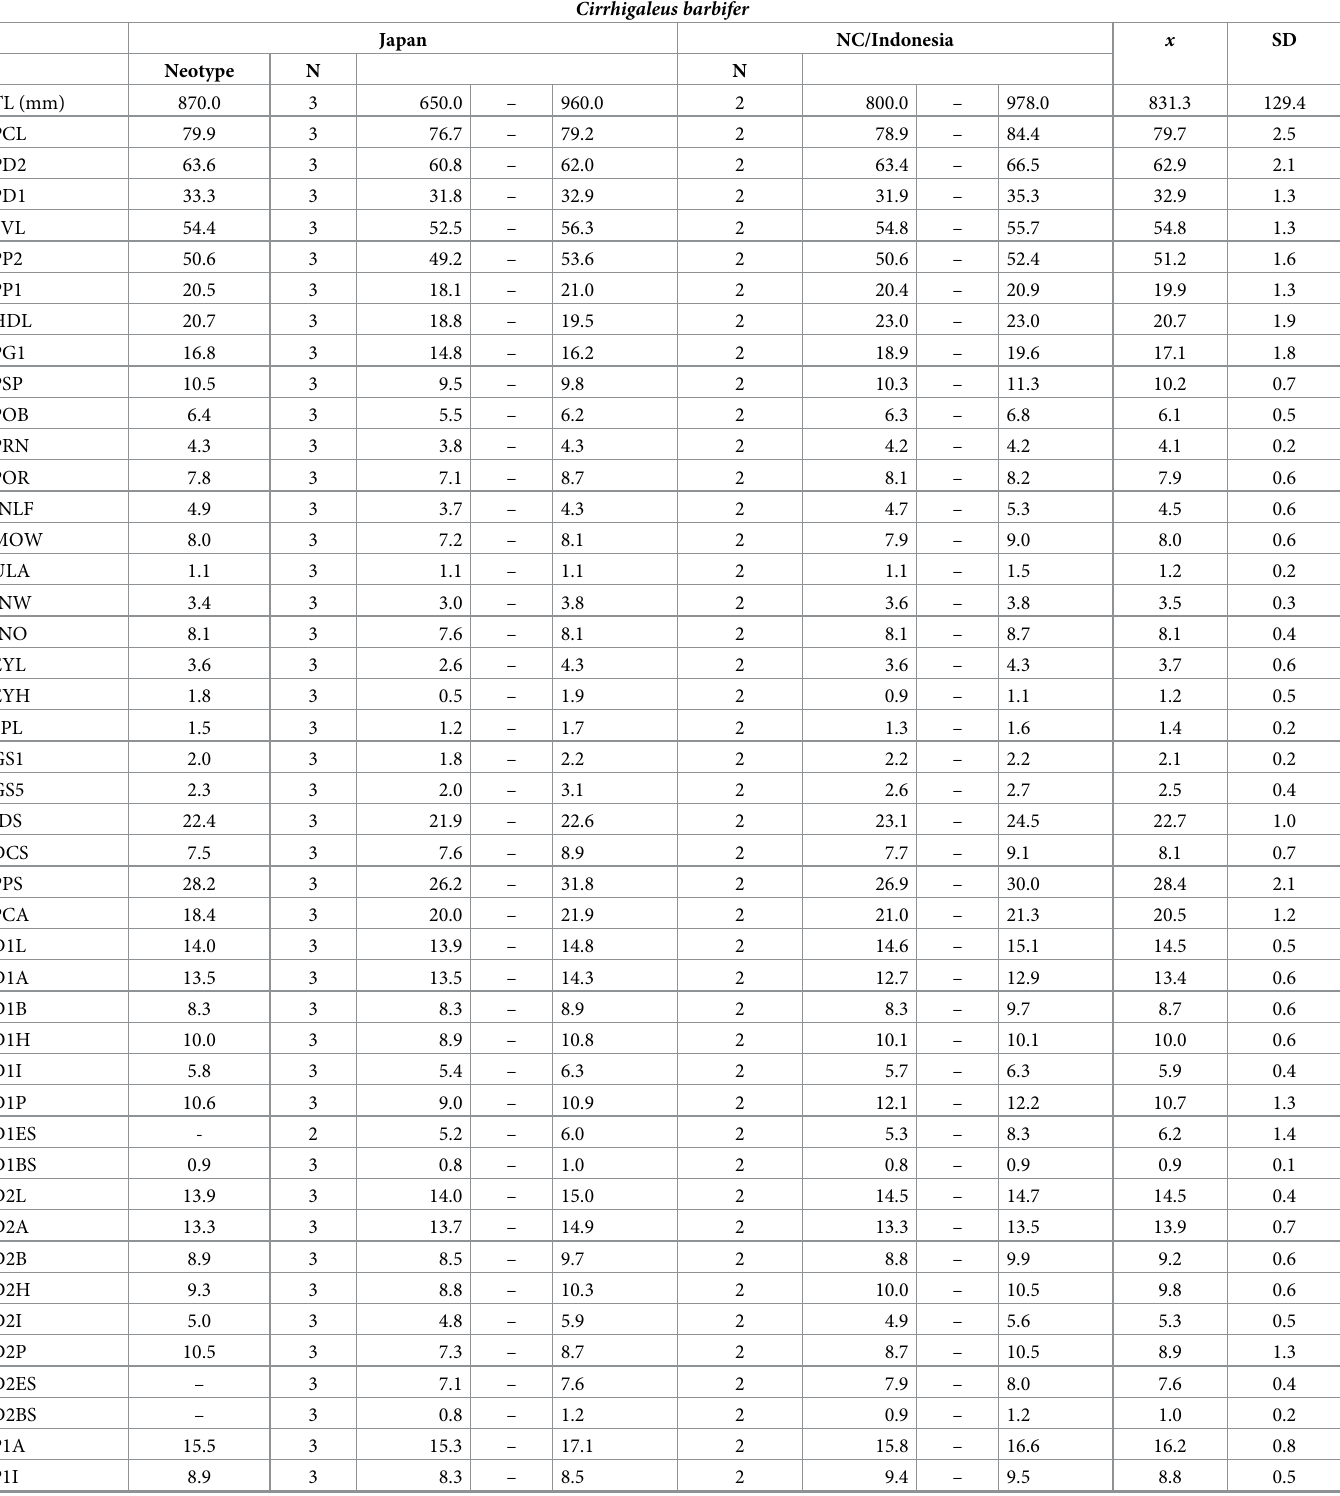
Table 1. External measurements of C . barbifer expressed as percentage of total length